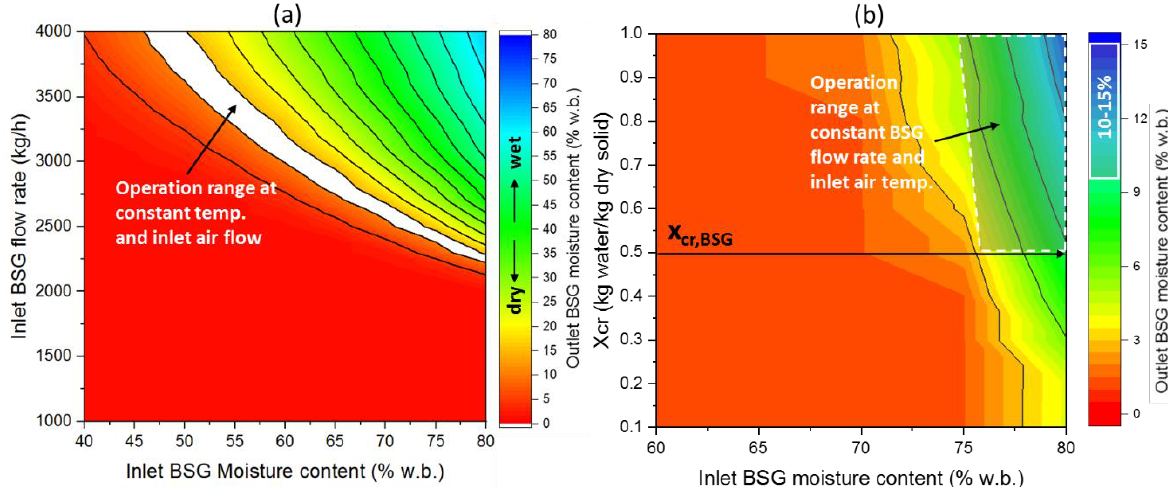
Figure 5. Effect of inlet BSG flow rate on the outlet moisture of BSG for ( a ) constant inlet air temperature and flow rate and ( b ) constant inlet air temperature as well as constant inlet air and BSG flow rates. Data points presented can be found in the Supplementary Information (Table S4 and Table S5).